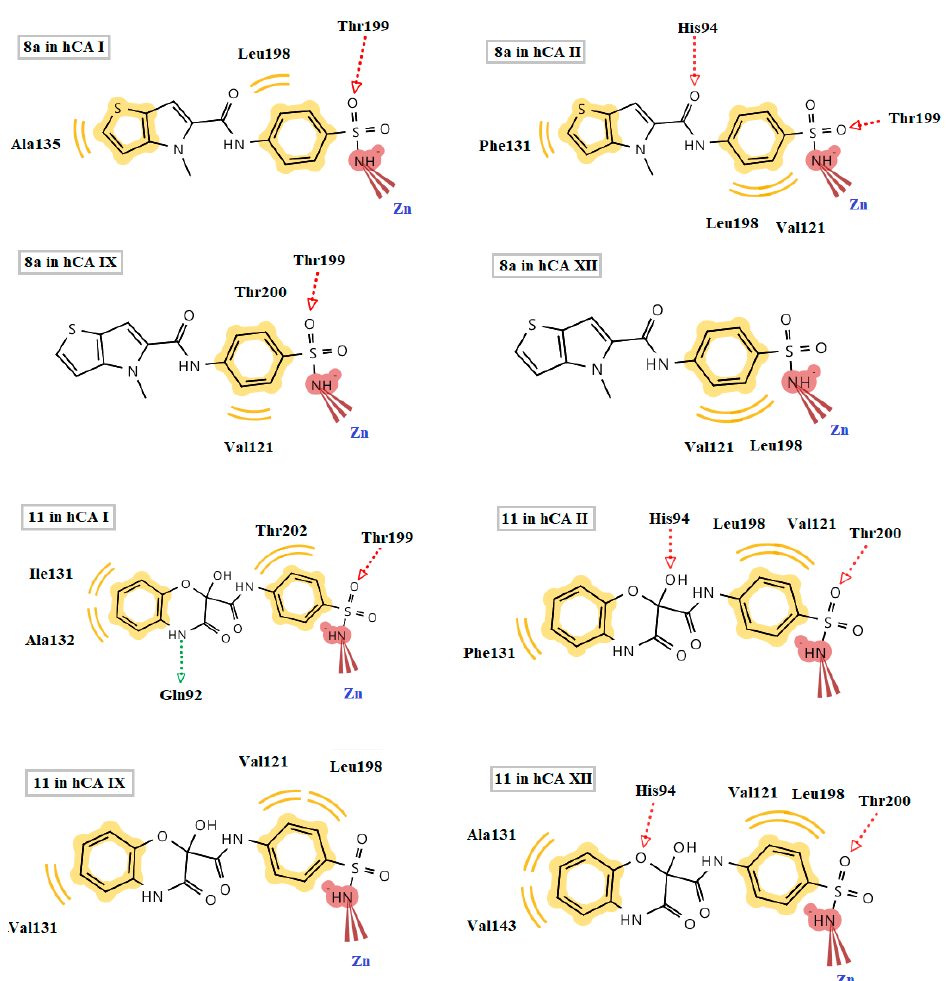
Figure 3. 2D interaction diagrams of compounds 8a and 11 docking poses interactions with the key amino acids in hCA I, hCA II, hCAIX, hCA XII.